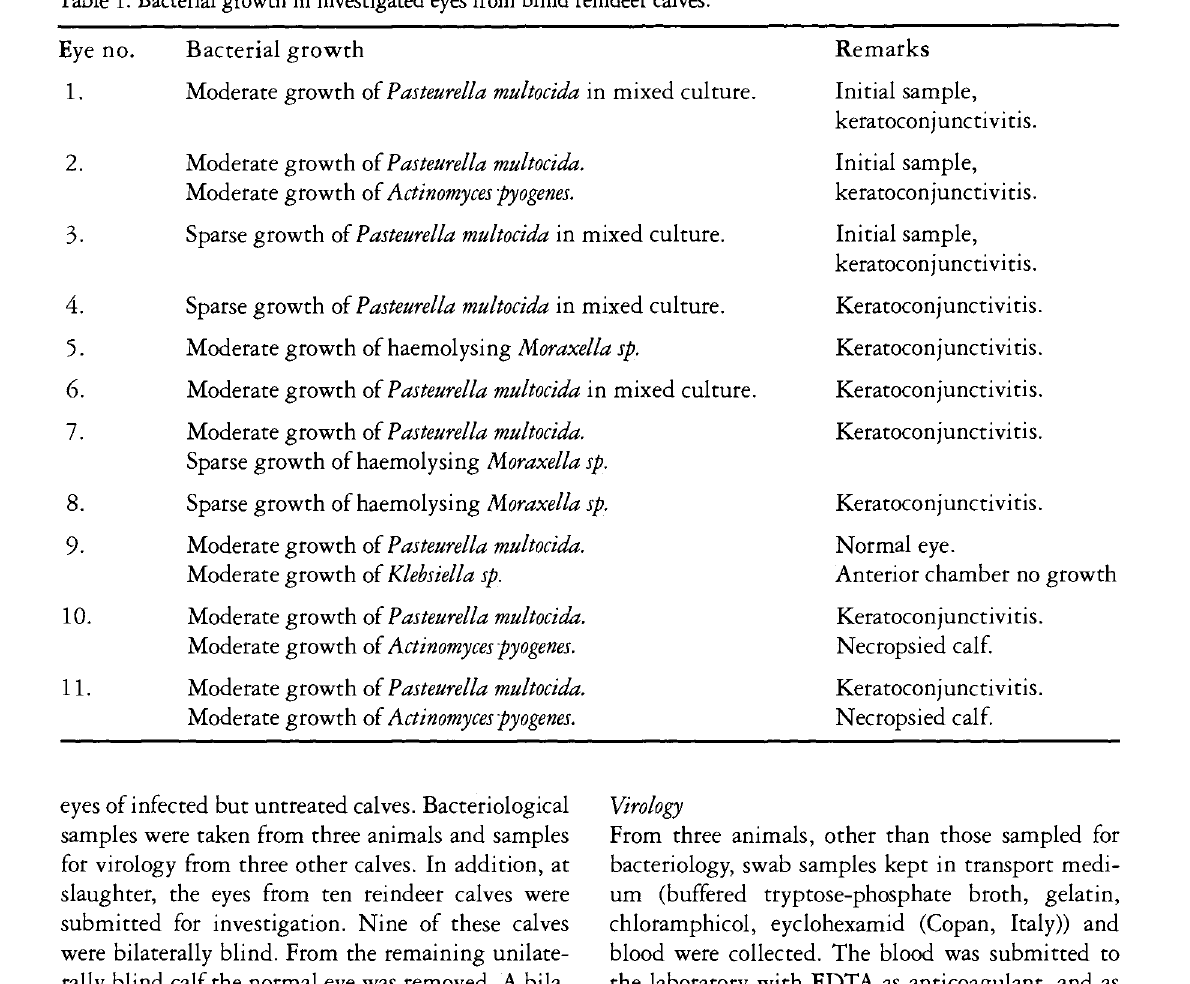
Table 1. Bacterial growth in investigated eyes from blind reindeer calves. Eye